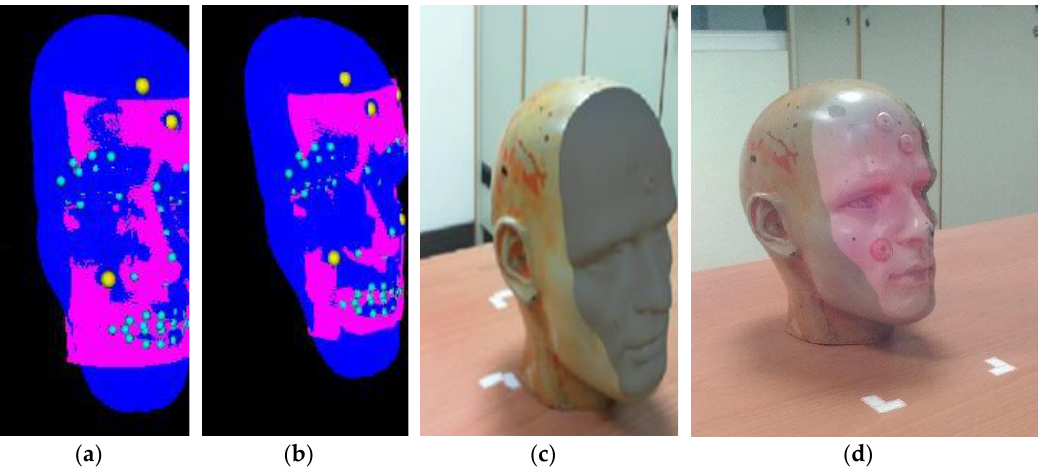
Figure 3. Sample alignment results. ( a ) Improved-ICP; ( b ) DRWP-ICP; ( c ) without HoloLens; and ( d ) with HoloLens.